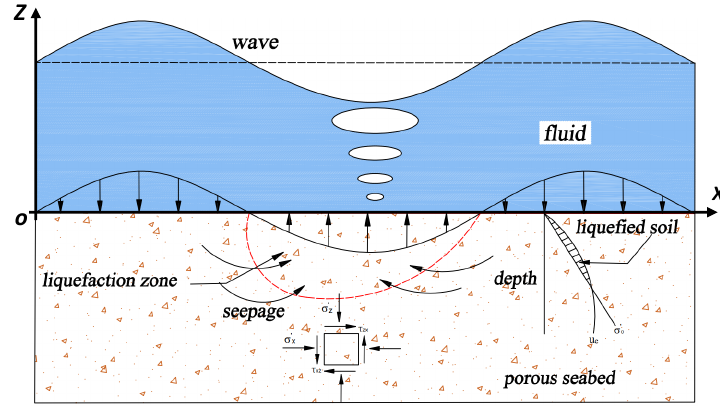
Figure 1. Sketch of the interaction between wave and seabed.